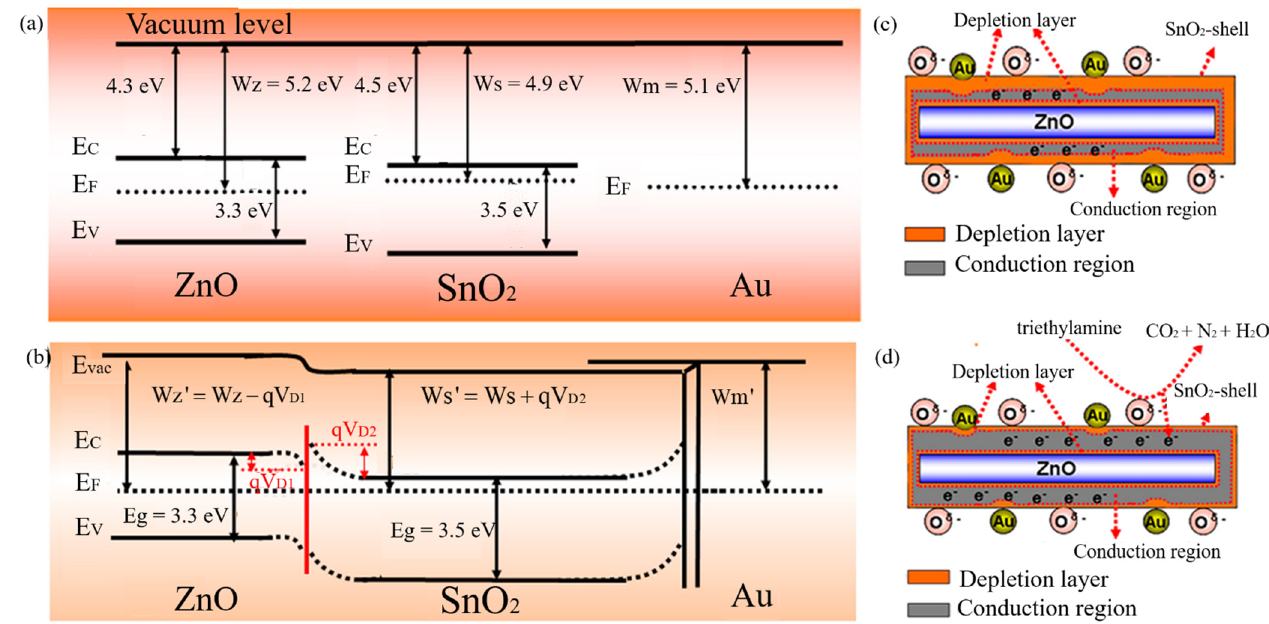
Figure 7. Schematic diagram of the mechanism of interaction between core–shell structure and noble metal nanoparticles. Reprinted from [114] copyright (2015), with permission from American Chemical Society. ( a ) Schematic diagram of energy bands for ZnO, SnO 2 , and Au; ( b ) Schematic diagram of energy bands for Au-SnO 2 /ZnO heterojunction; ( c ) Schematic diagram of Au-SnO 2 /ZnO sensor exposed to air; ( d ) Schematic diagram of Au-SnO 2 /ZnO sensor exposed to TEA.